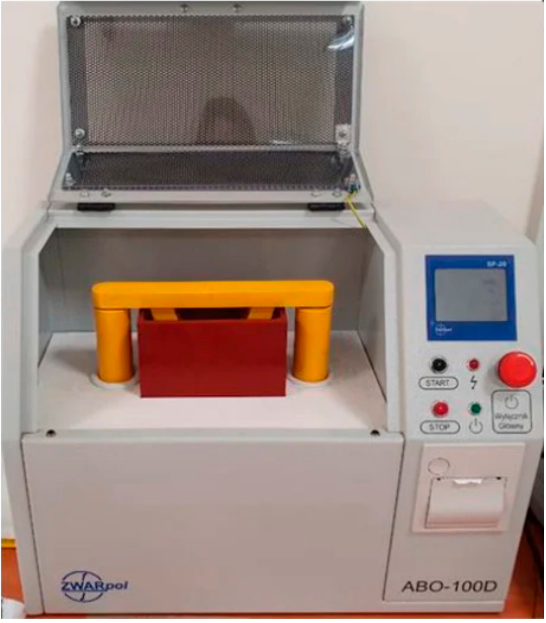
Figure 4. Used breakdown voltage tester.